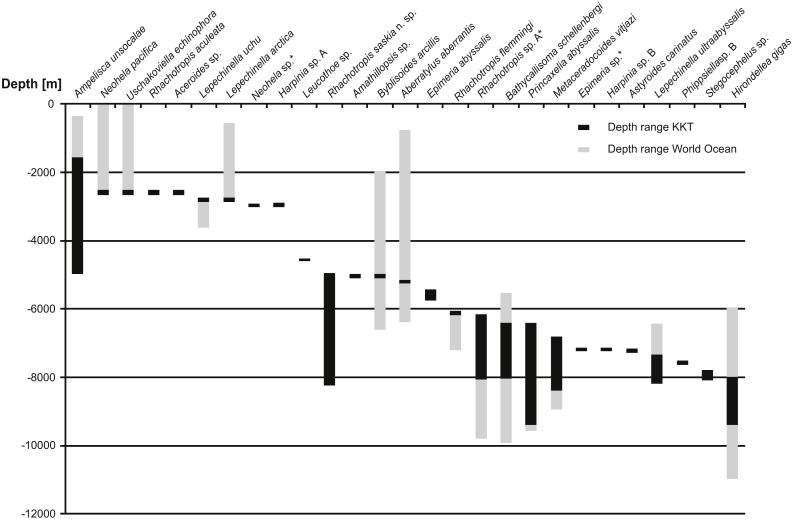
Depth ranges of benthic species recorded in Kuril Kamchatka Trench area.Only the species recorded in KKT below 2,000 m are shown. The species are organized by the shallowest record in KKT. Grey bars indicate the known depth range, the black bars show the depth range in KKT area.